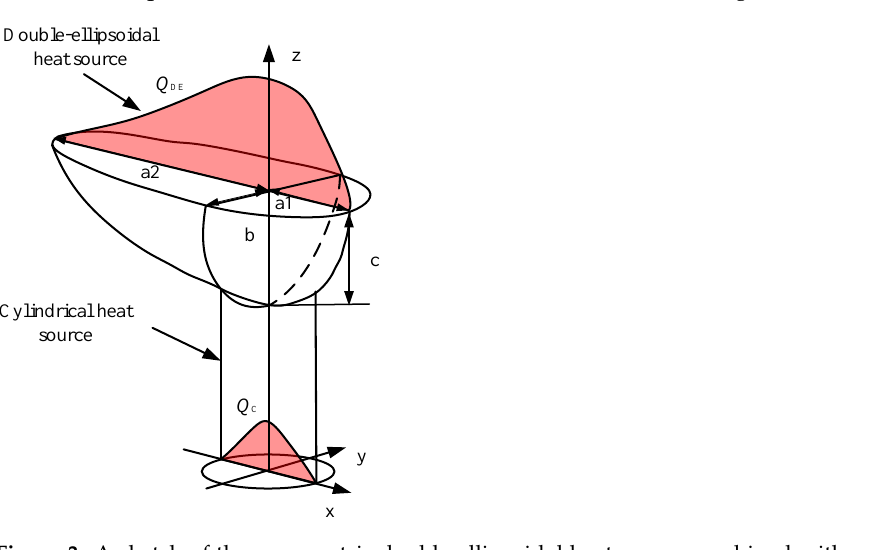
Figure 3. A sketch of the asymmetric double-ellipsoidal heat source combined with a cylindrical heat source.